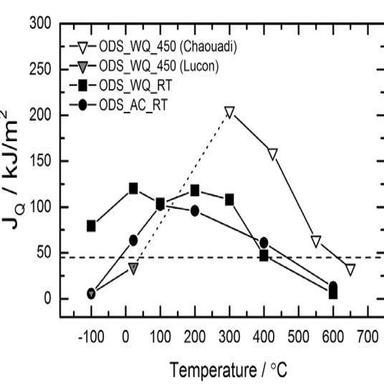
Fracture toughness comparison over a wide temperature range for ODS_AC_RT and ODS_WQ_RT along with ODS_WQ_450 (taken from Chaouadi et al. \). For ODS_WQ_450, the results for −100 ˚C and 22 ˚C are taken from Lucon (grey symbols). A dotted line is used to connect the two set of values for ODS_WQ_450. The dashed line indicates the acceptable fracture toughness value of JQ = 45 kJ/m2 (KJQ = 100 MPa√m)